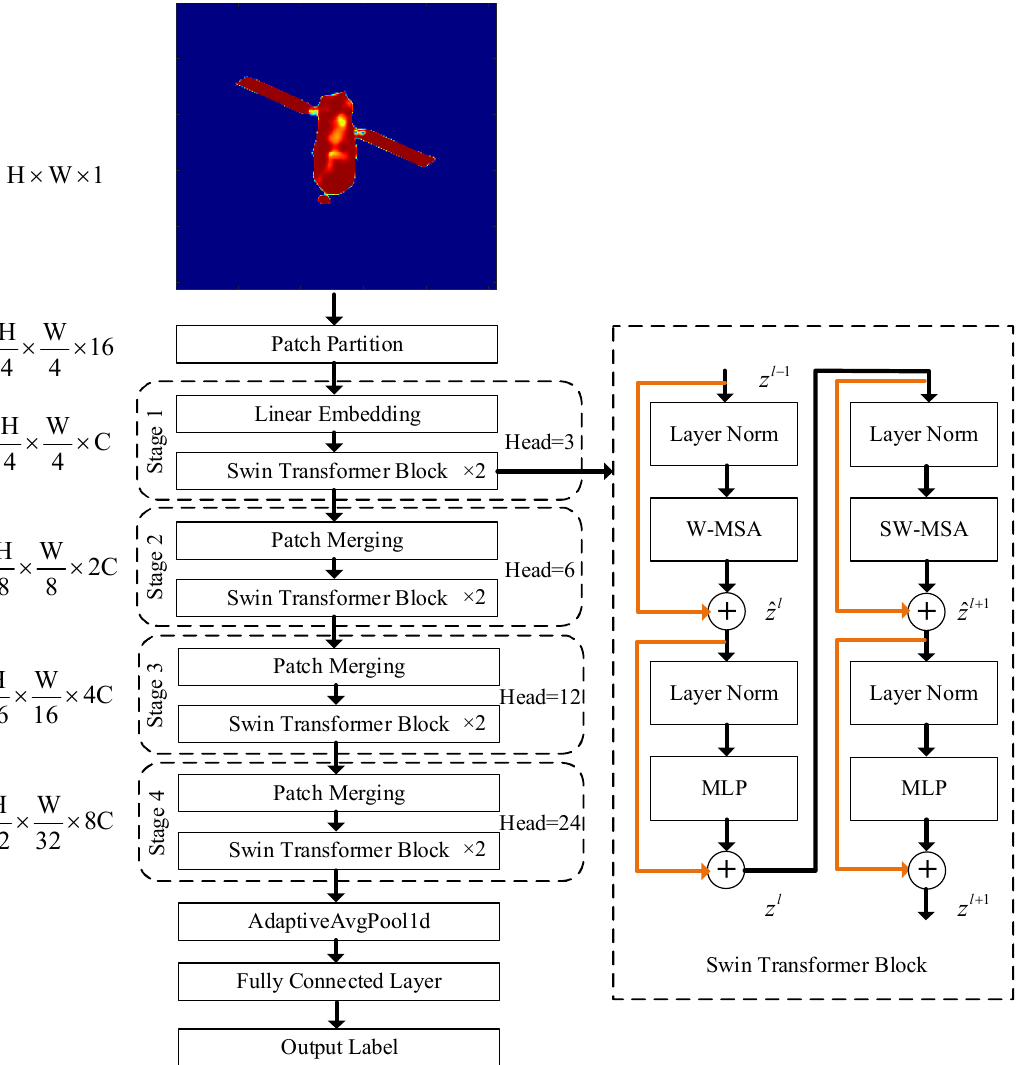
Figure 7. Flow chart of attitude estimation based on swin transformer.